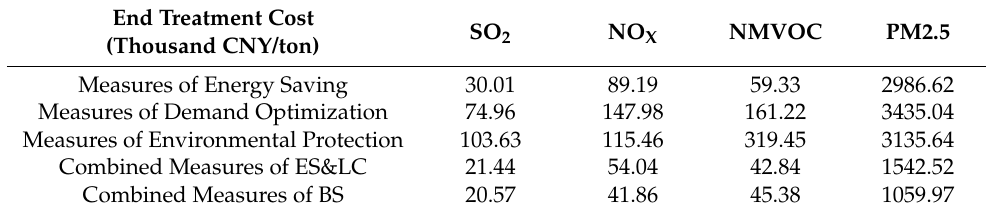
Table 7. Unit end-of-pipe treatment costs of energy saving and emission